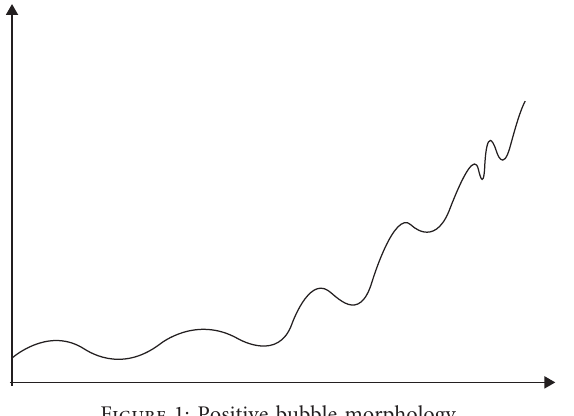
Figure 1: Positive bubble morphology.